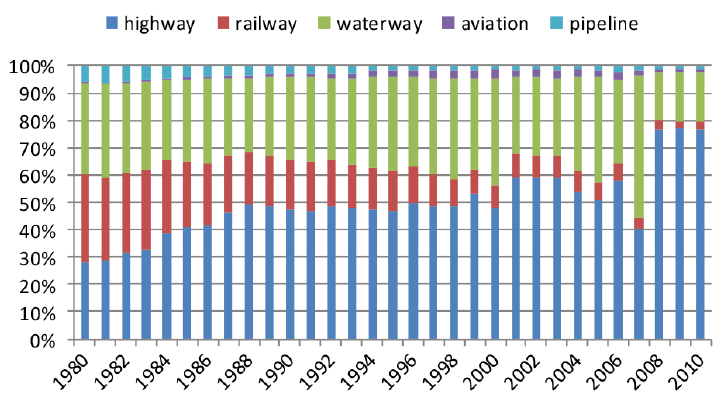
Figure 3. Percentage of CO 2 emission in different transport